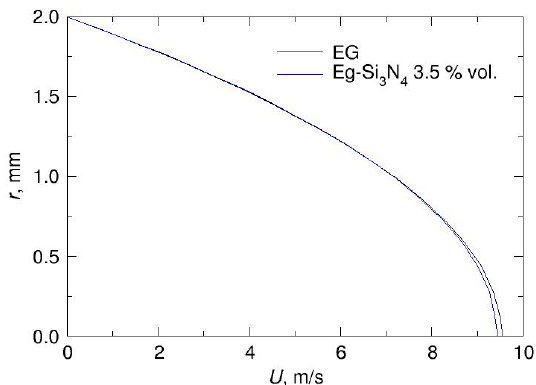
Figure 7. The computed velocity profile for laminar flow of pure EG and of EG-Si 3 N 4 nanofluid with the nanoparticle volume fraction of 3.5% at Q = 6 × 10 − 5 m 3 /s, which corresponds to Re = 1500 for pure EG.